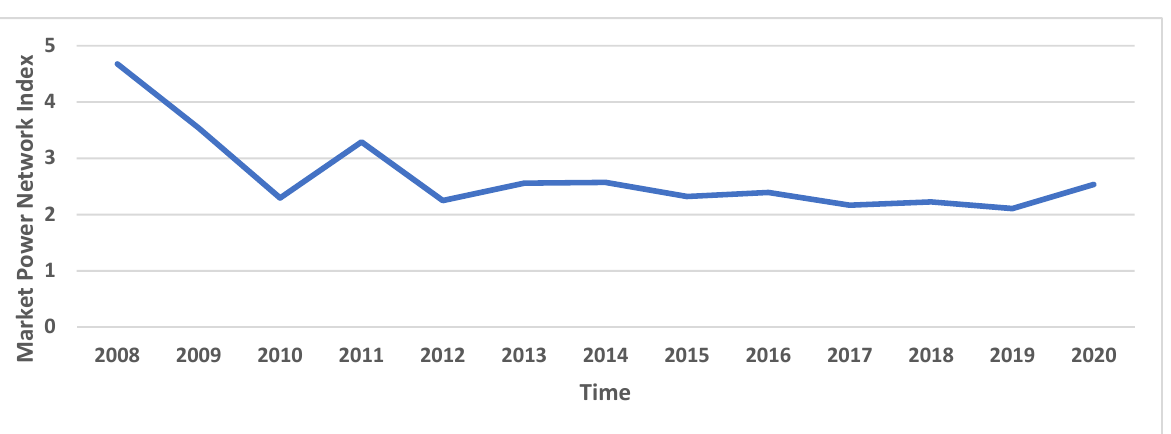
Figure 2. Market Power Network Index for Indian banks. Source: Authors’ own contribution. Figure 3 depicts the time-varying annually estimated market power in the form of a network index for the Indian banking system. The index value was the highest during the GFC, thereby indicating that banking competition is the least during periods of crisis. The COVID-19 period is also marked with an increasing index value trend, indicating lower competition but still more than the GFC.